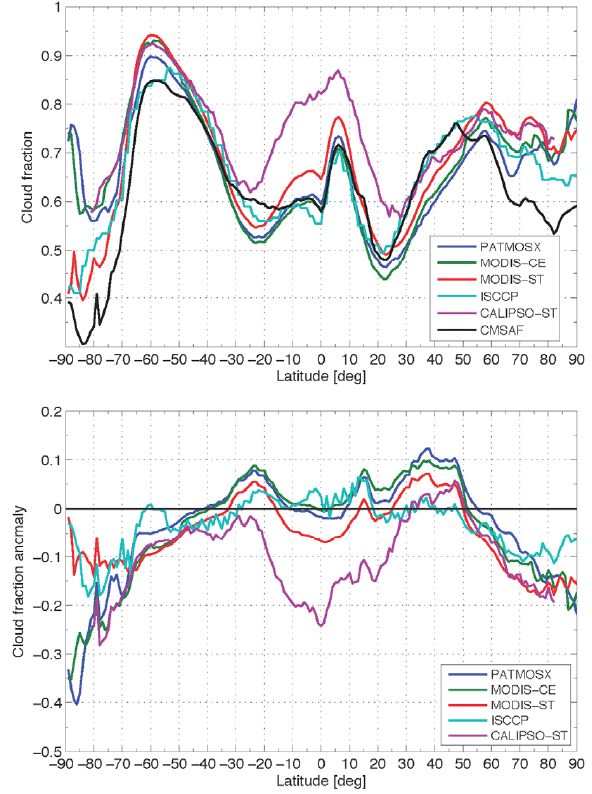
Fig. 3. Annual zonal mean cloud fraction for the NOAA-18 ascend- Figure 3. Annual zonal mean cloud fraction for the NOAA-18 ascending orbit (13:30 local 2 ing orbit (13:30 local solar time) for CLARA-A1 (CM SAF, black solar time) for CLARA-A1 (CM SAF, black curve) and five other global cloud datasets for 3 curve) and five other global cloud datasets for 2007 (top panel) and 2007 (top panel) and the resulting differences to CLARA-A1 (bottom panel). 4 the resulting differences to CLARA-A1 (bottom